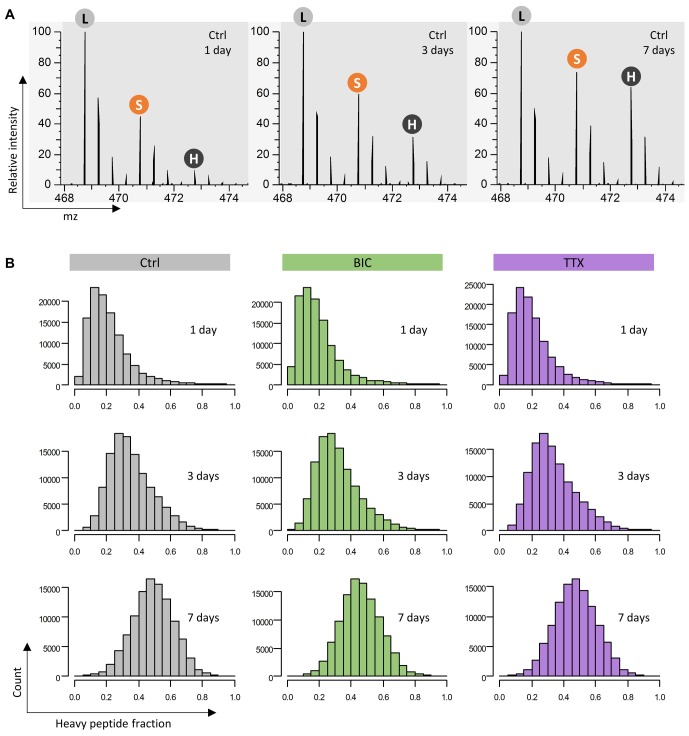
Heavy amino acid incorporation.(A) Exemplary MS1 spectra of the peptide ‘ILGDYDIK’ (tryptic product of protein Synapsin-2) after 1, 3 and 7 days of heavy SILAC pulse. The monoisotopic peaks of the light (L), semi-heavy (S) and heavy (H) isotopologues are indicated. (B) Distributions of heavy peptide fractions for each time point and treatment condition.